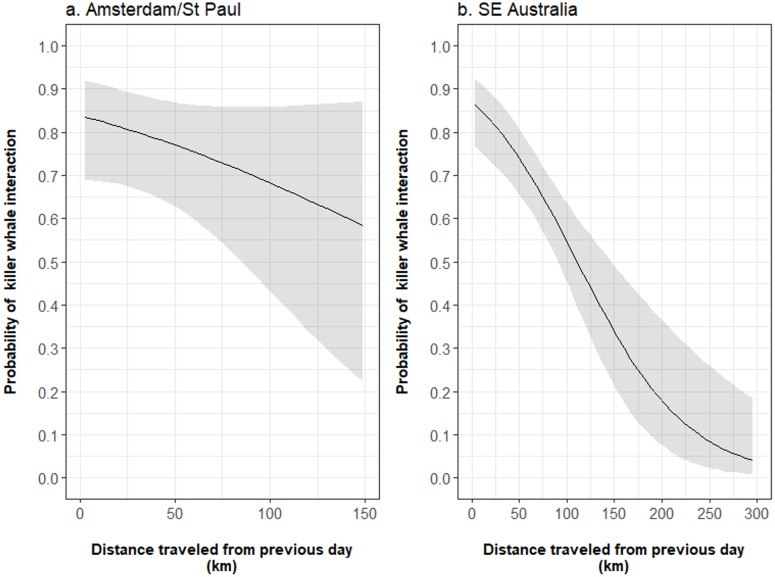
Influence of the distance travelled by vessels from one fishing day during which killer whale interaction occurred to the next on the probability of killer whale interaction during the next day.The mean probability (black line) and 95% confidence intervals (grey shade) were estimated from the output parameters of the final Generalised Linear Models fitted to the occurrence of killer whale interaction during fishing days in (A) Amsterdam/St. Paul and (B) SE Australia.